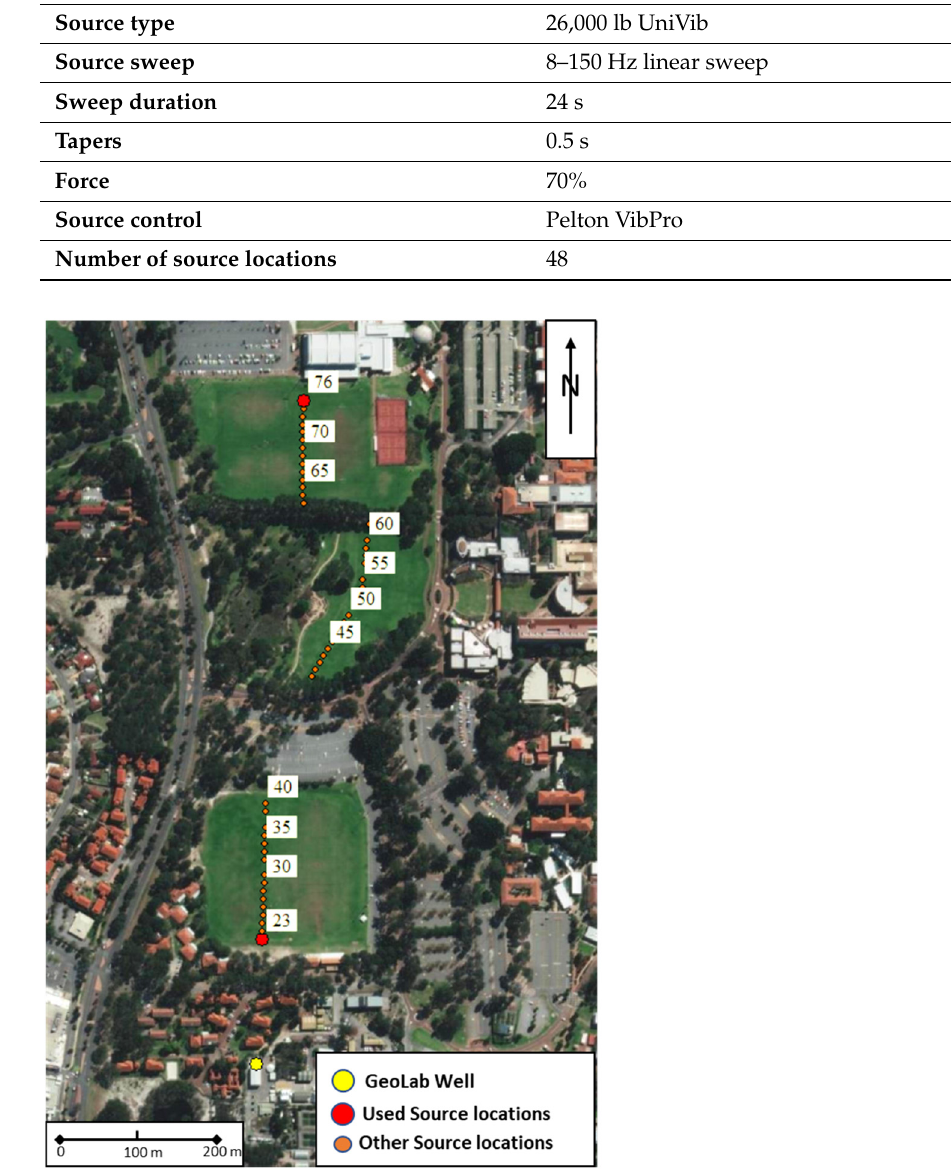
Figure 3. Aerial map showing the surface location of the well (blue) and source positions (red); every fifth source station is